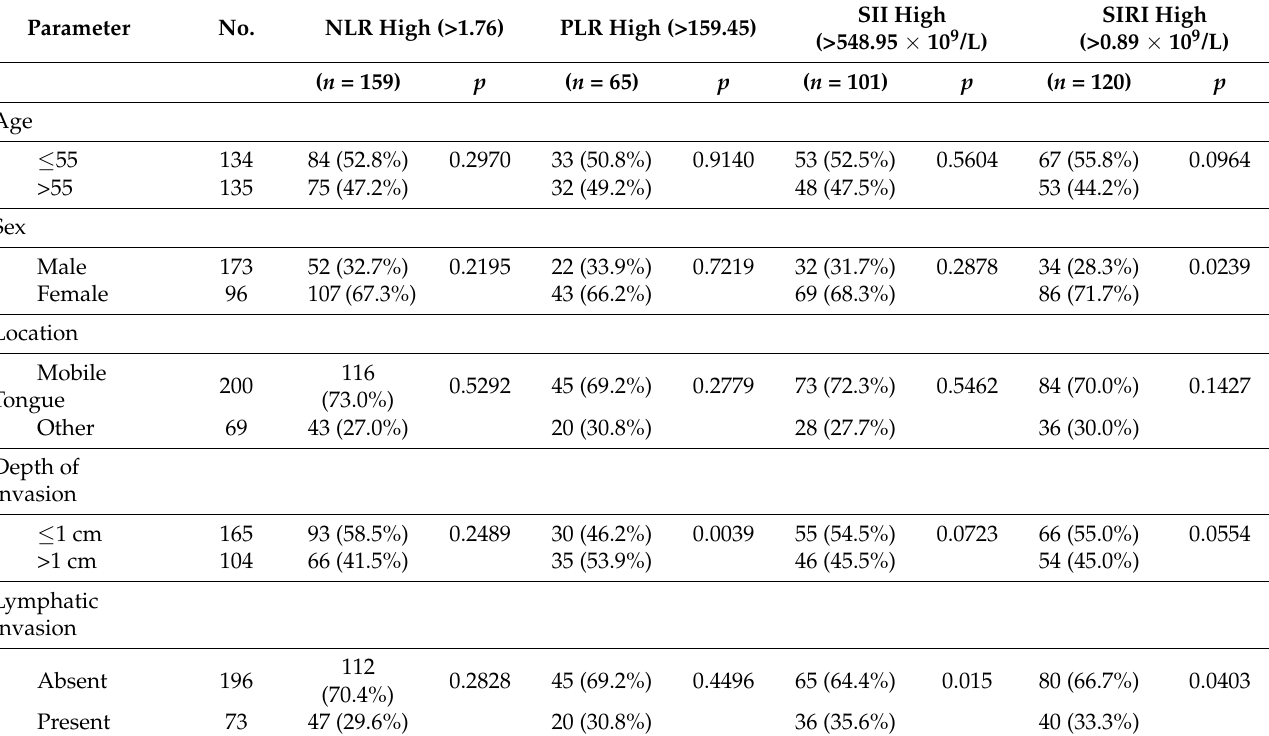
Table 4. Correlation between clinicopathologic parameters and systemic inflammation